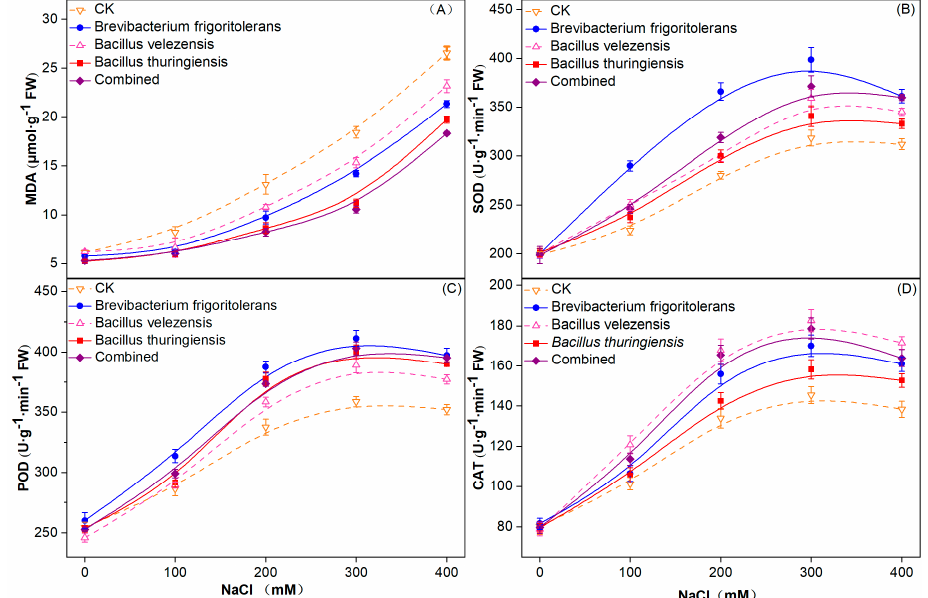
Figure 4. Effects of salt ‐ tolerant plant growth promoting rhizobacteria (ST ‐ PGPR) on ( A ) malondial ‐ dehyde (MDA) contents, ( B ) superoxide dismutase (SOD), ( C ) peroxidase (POD), and ( D ) catalase (CAT) activity in wheat under NaCl stress.